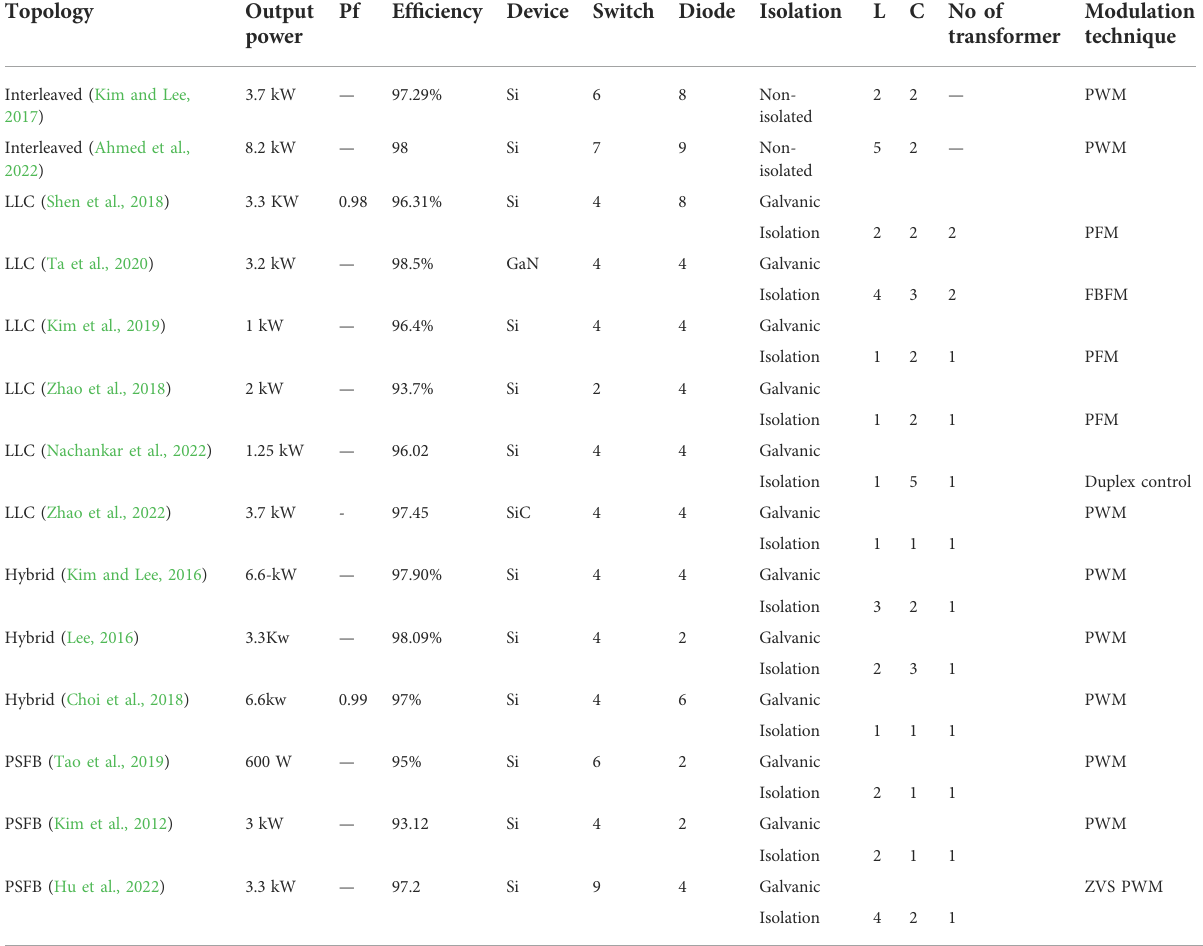
TABLE 4 Two-stage unidirectional converter summary.